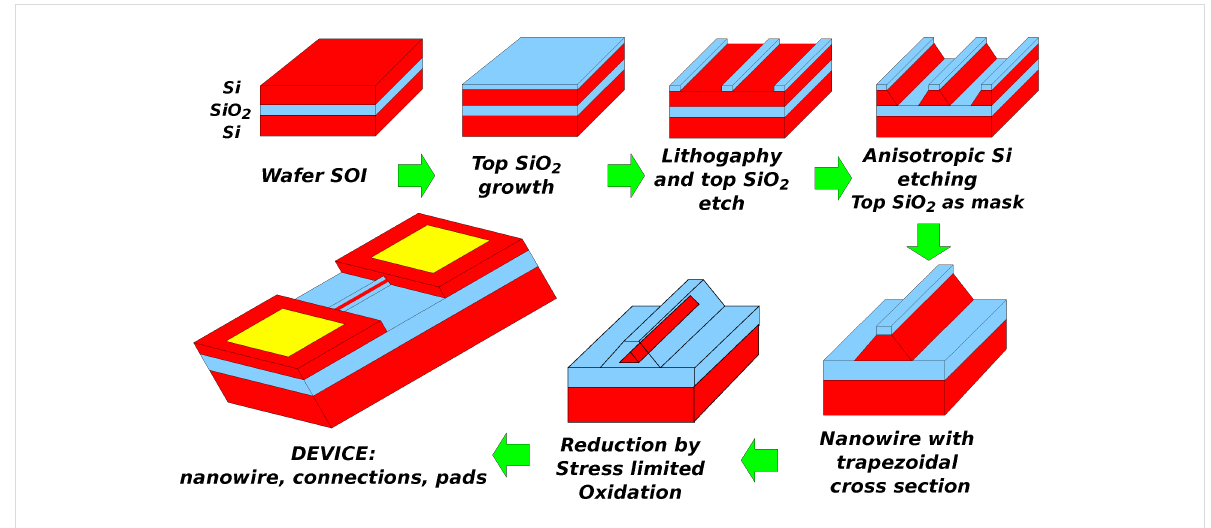
Figure 7: Sketch of a top-down fabrication process for a device based on a silicon nanowire.